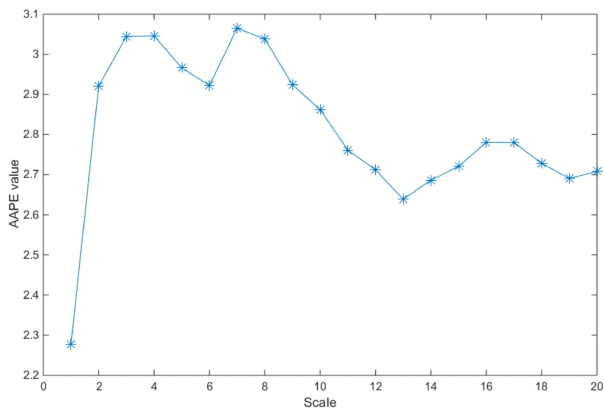
Figure 4. MAAPE feature values of rolling bearing vibration signal under normal condition.